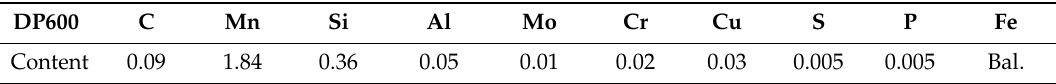
Table 2. The chemical composition of DP600 galvanized steel (in wt%).